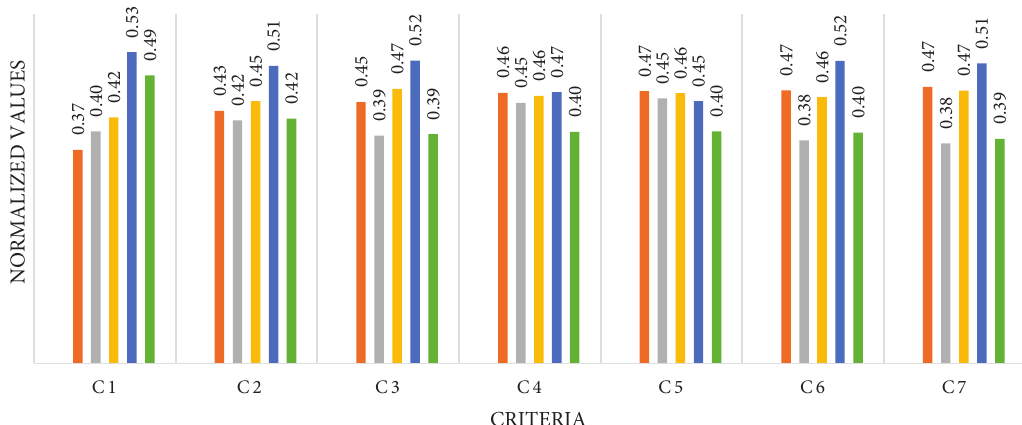
Figure 11. Bar chart for criteria comparison of the